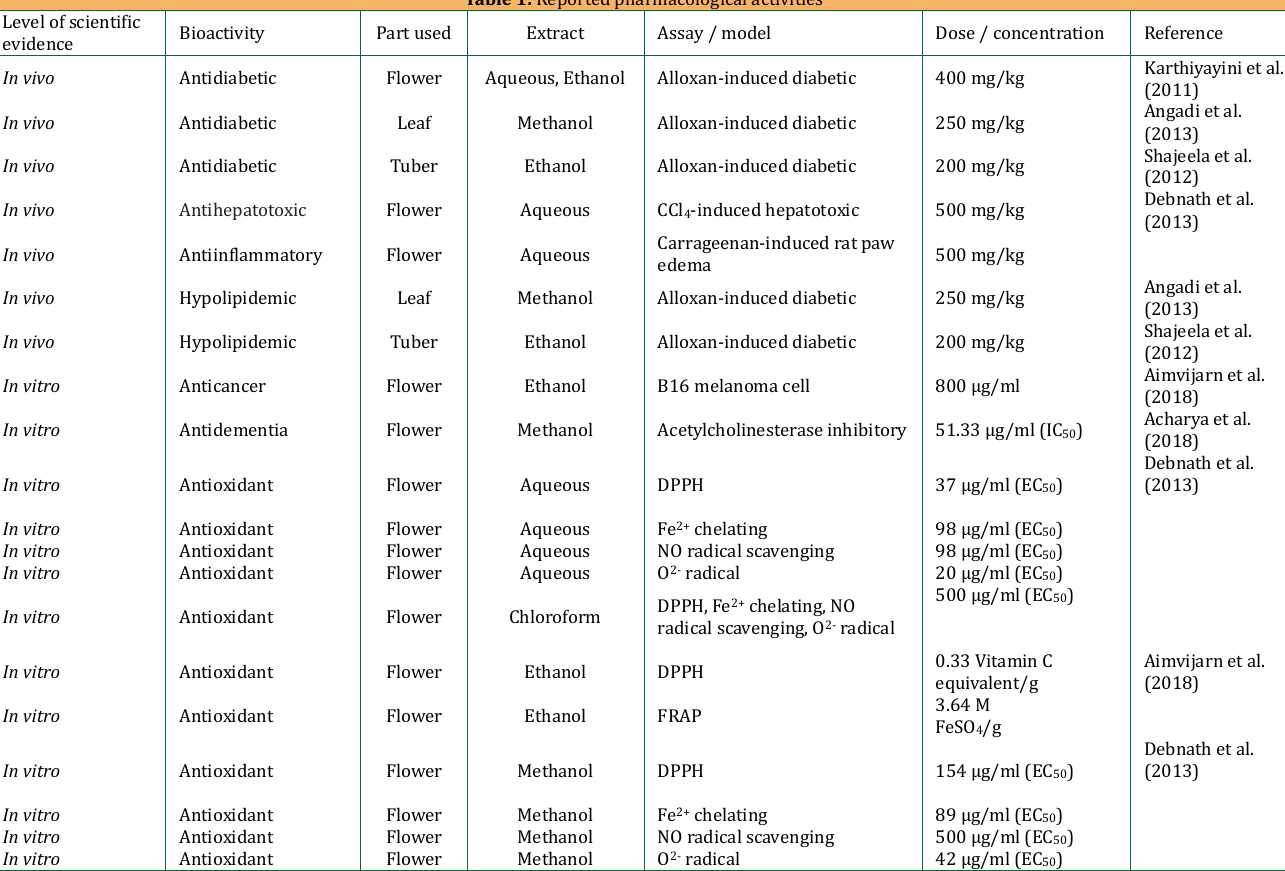
Table 1: Reported pharmacological activities